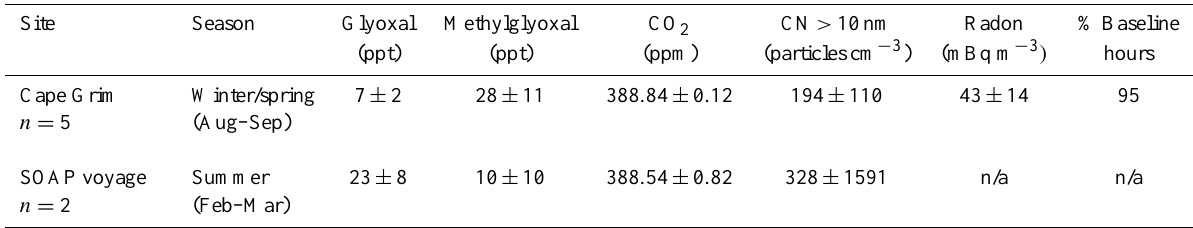
Table 1. Mixing ratios of glyoxal and methylglyoxal in clean marine air at Cape Grim and Chatham Rise, with supporting measurements of carbon dioxide, condensation nuclei (CN) > 10nm and atmospheric radon-222. Values are average ± SD. n stands for the number of 24h